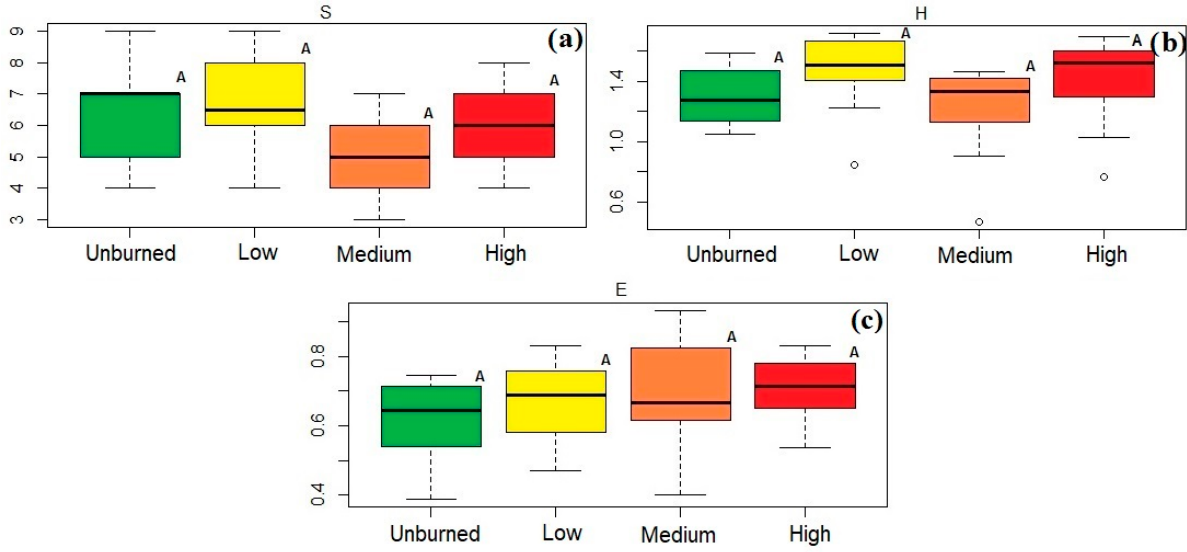
Figure 2. Tukey’s multiple comparison test of ( a ) species richness ( S ), ( b ) Shannon Index ( H ), and ( c ) Evenness Index ( E ) by fire severity level. Different letters indicate significantly different means ( p < 0.05); the same letters indicate non-significant differences. The similarity analysis showed two groups: one, zones affected by LS and U fire, and two, zones affected by MS and HS fires, indicating similarity of species (Figure 3).